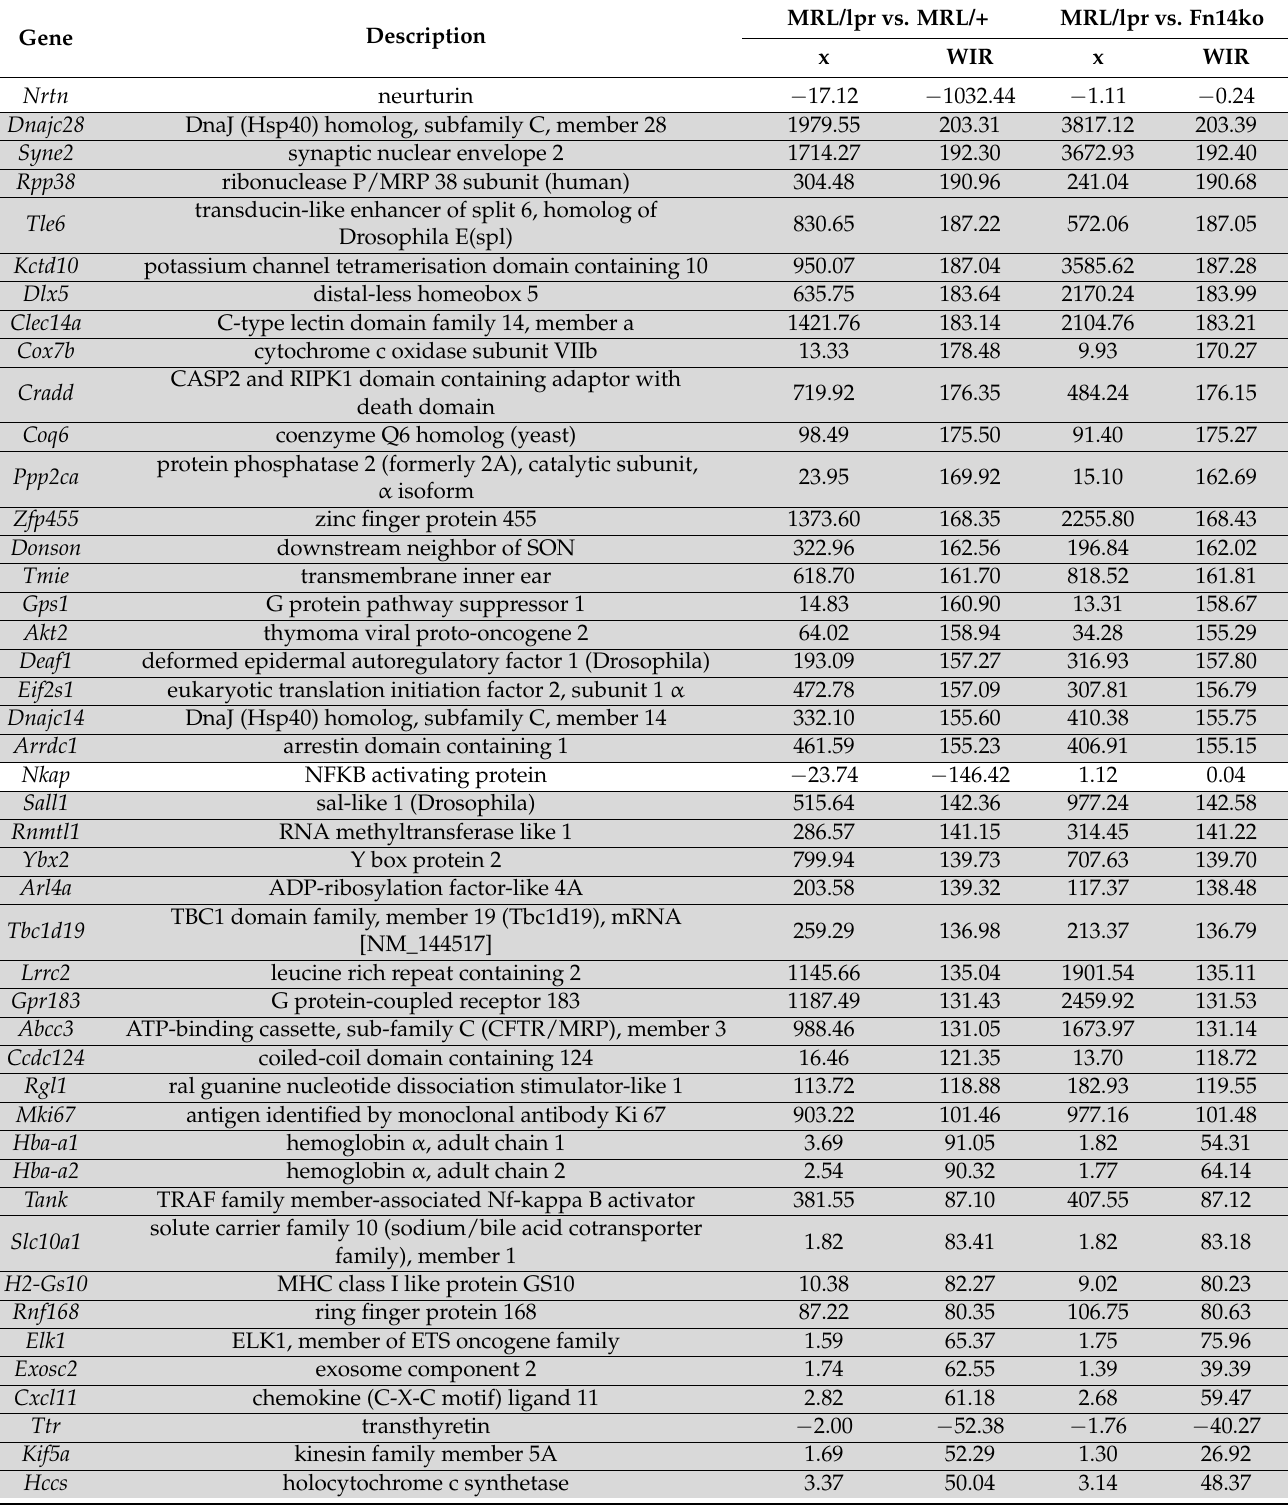
Table 2. The 60 genes that are the largest contributors to the MRL/lpr phenotype. Positive values indicate upregulation of the gene in the MRL/lpr compared with MRL/+ and Fn14ko, and negative values indicate its downregulation. Shaded genes are ones with a similar trend in both control phenotypes, indicating that TNF-like weak inducer of apoptosis (TWEAK)/Fn14 activation plays a role in the gene’s regulation. “x”, expression ratio/fold-change; “WIR”, Weighted Individual (gene)